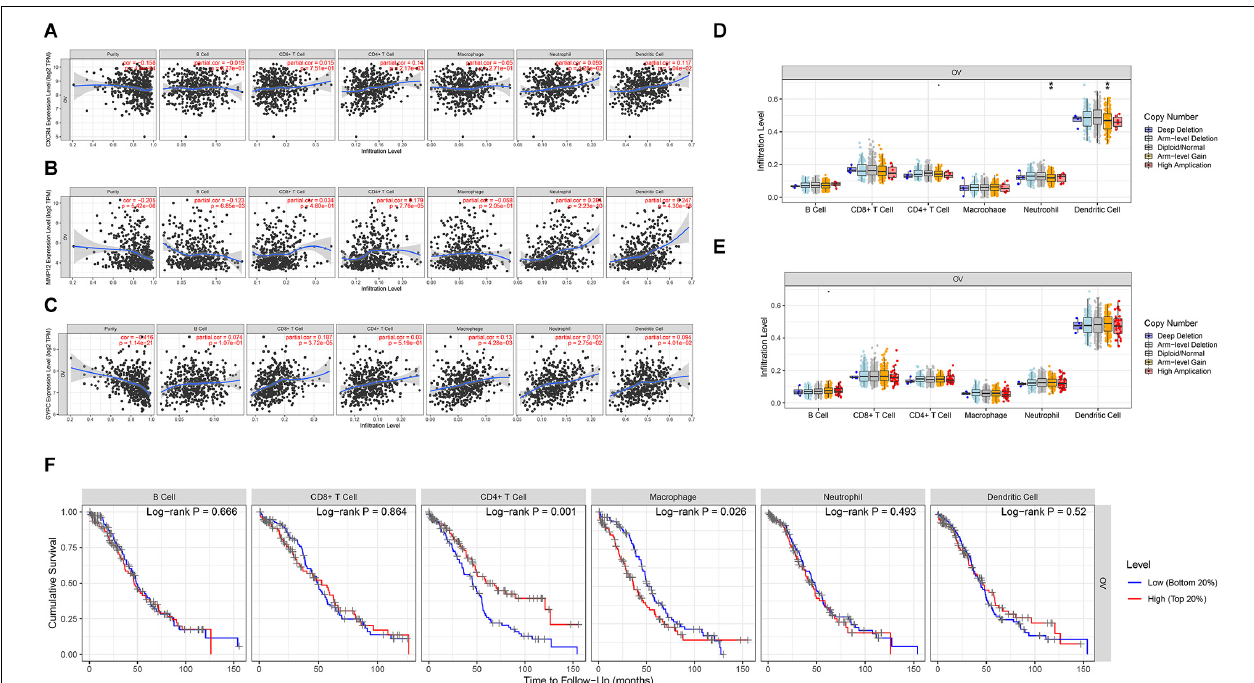
FIGURE 5 | Evaluation of the association between three prognostic signatures, immune cells, and survival. Three prognostic signatures associated with immune cell infiltration. (A) CXCR4, (B) MMP12, (C) GYPC. (D,E) Association of three prognostic signature mutants with immune cell infiltration. (D) The arm level gain of GYPC was correlated with neutrophils and dendritic cells. (E) The SCNA level of MMP12 was not significant with immune infiltration. Association between CXCR4 mutants with immune cell infiltration was not detected by the SCNA module of timer. (F) Survival analysis of differentially immune cells. Low infiltration level of macrophage cells and high infiltration level of CD4+ T cells correlated with favorable survival outcomes. Statistical significance was defined by a P value: *** means 0 ≤ P value < 0.001, ** represents 0.001 ≤ P value < 0.01, * represents 0.01 ≤ P value < 0.05, means 0.05 ≤ P value <